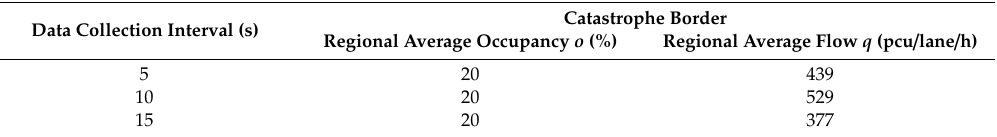
Table 5. Catastrophe border identification at di ff erent time intervals.